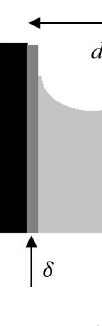
Figure 3. Illustration of a meniscus in a pore of wet gel. Adopted with permission from [10].